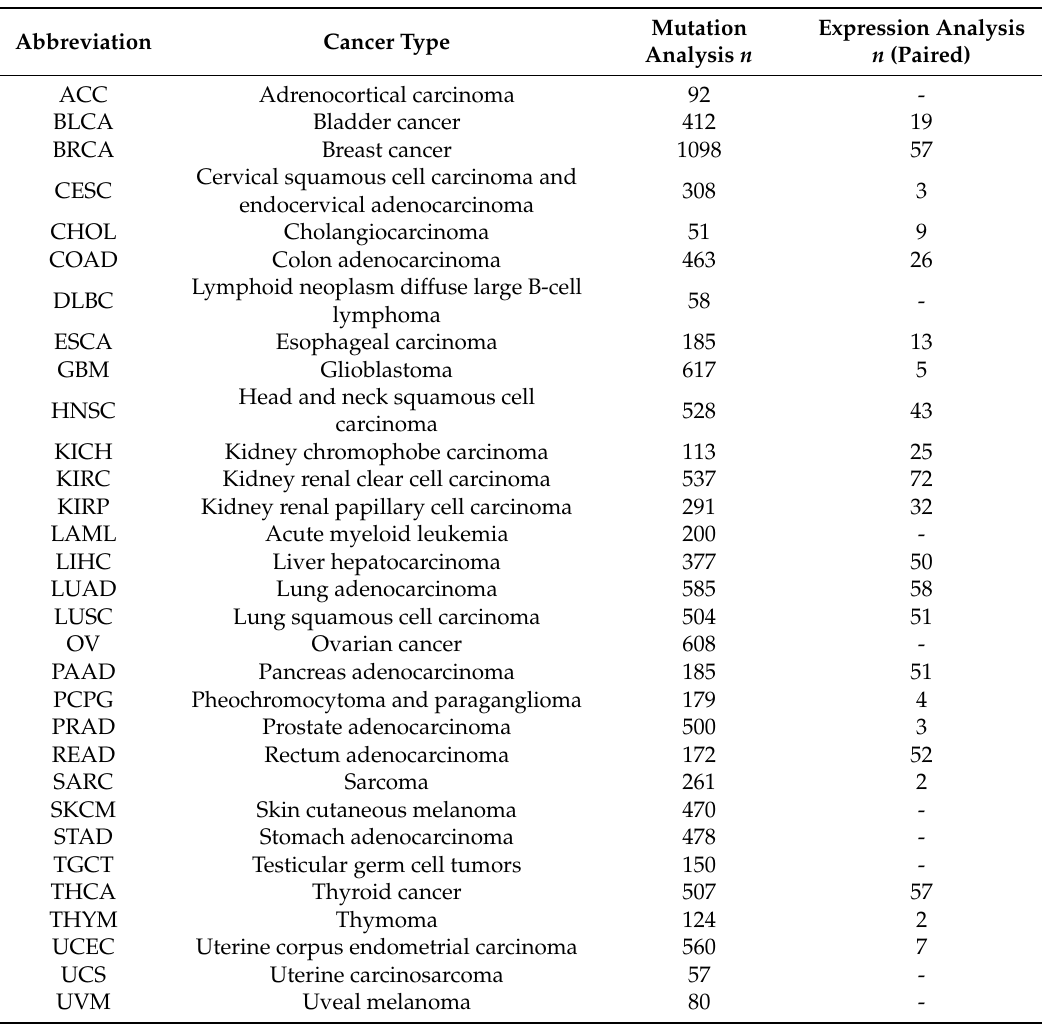
Table 1. List of cancer types and number of patients ( n ) analyzed from TCGA (The Cancer Genome